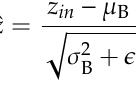
Table 3. SlimDeblurGAN: DeblurGAN generator architecture after the model pruning process (CL— convolutional layer).